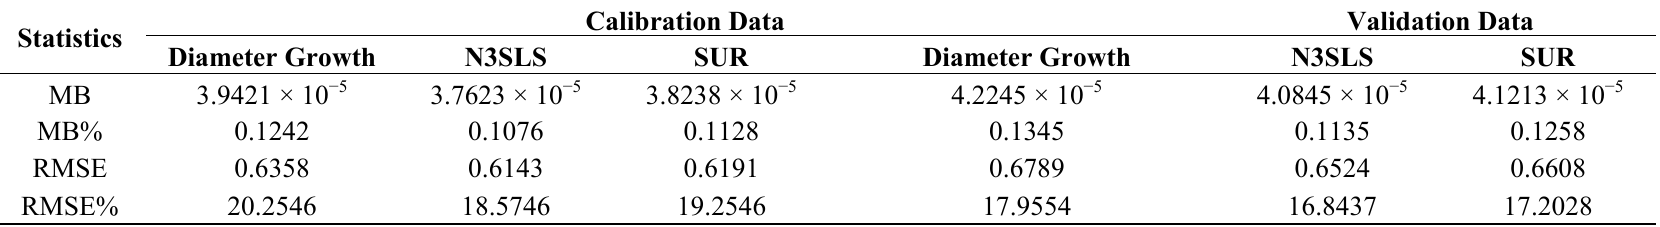
Table 7. Estimated errors of separate diameter growth model and simultaneous equation using N3SLS and